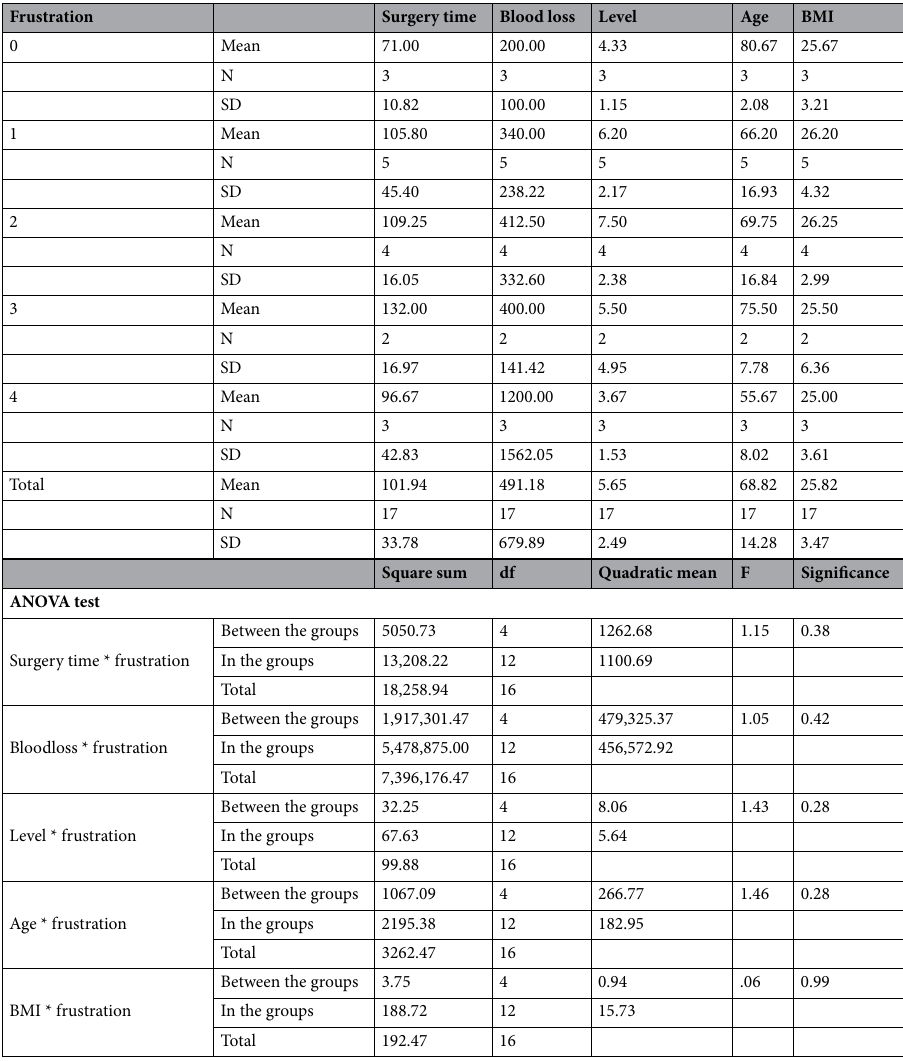
Table 3. Mean/Standard deviation and ANOVA test for frustration based on surgery times, bloodloss, spine level, age and